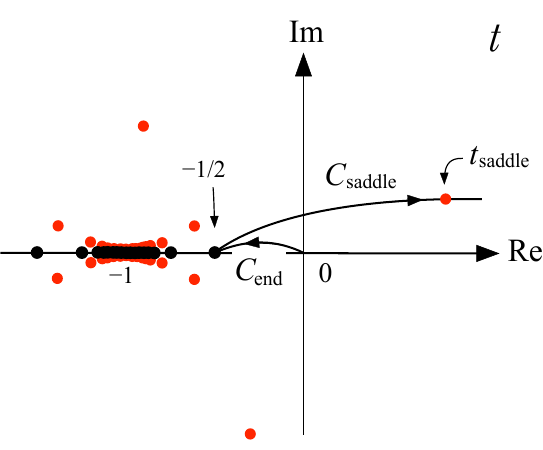
Figure 7 . Components of the steepest descent contour of the ghost number zero tachyon with (cid:21) = (cid:0)j (cid:21) j e i(cid:18) and 0 (cid:20) (cid:18) < (cid:25)= 2. In this range of angles, C saddle makes the dominant contribution to the asymptotic behavior. We plot the contour for (cid:12)nite (cid:11) so that the saddle point t saddle can be seen on the same scale as the singularities on the negative real